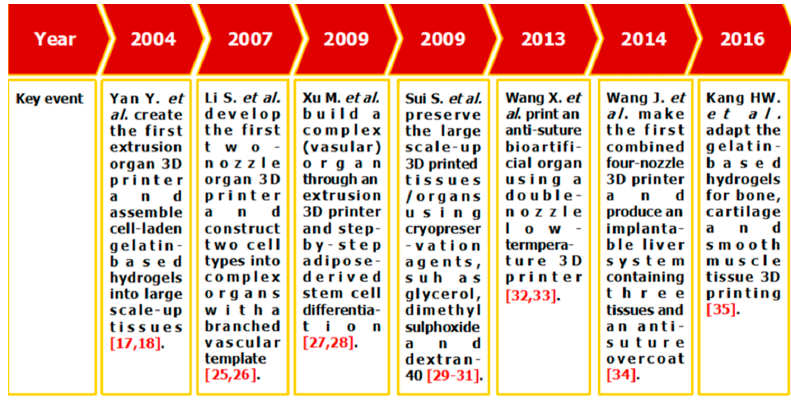
Figure 2. Histoical events of organ 3D bioprinting technologies.